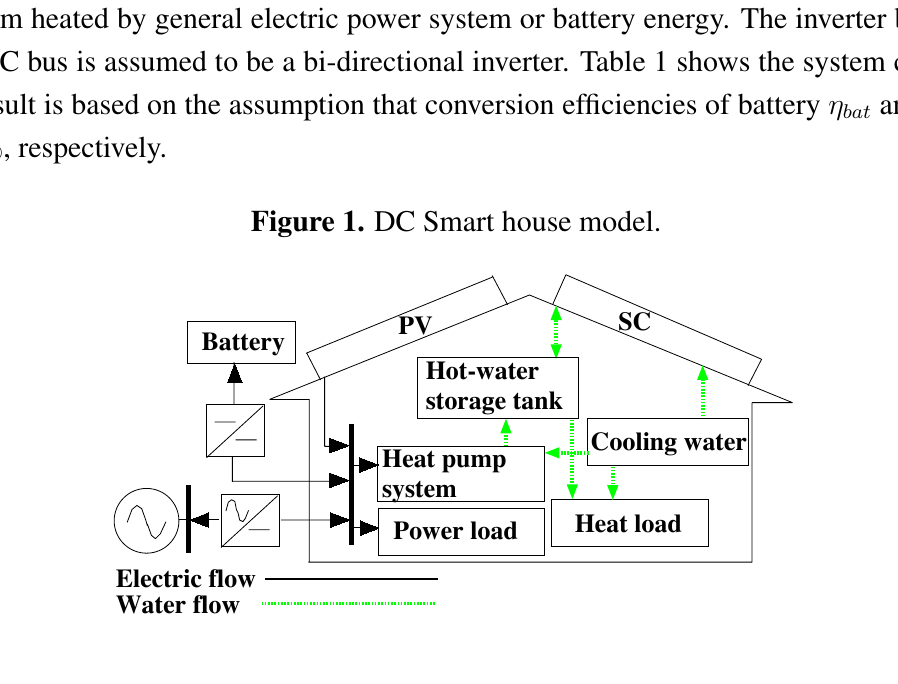
Table 1. System capacities (Size of general-purpose model in